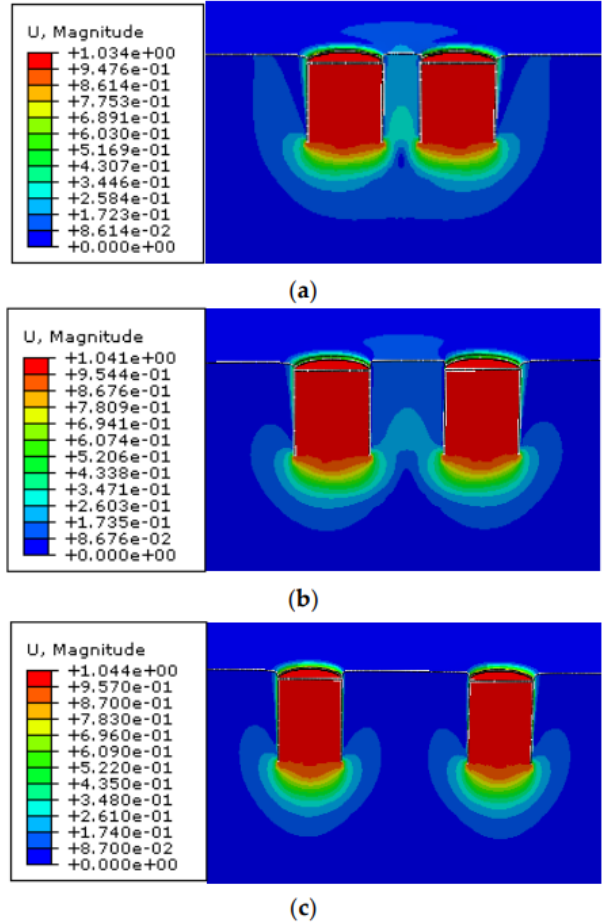
Figure 7. Displacement contours under vertical loading: ( a ) S / D = 0.5; ( b ) S / D = 1; ( c ) S / D = 2.